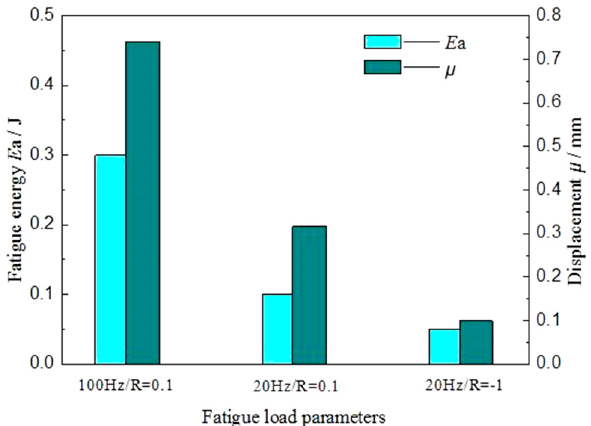
Figure 8. Histogram of displacement deformation and fatigue fracture absorbed energy of dissimilar Al/steel keyhole-free FSSW joints under different fatigue